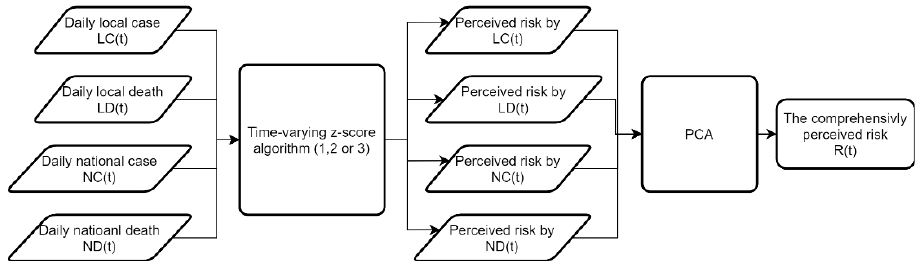
Figure 1. The perceived risk generation